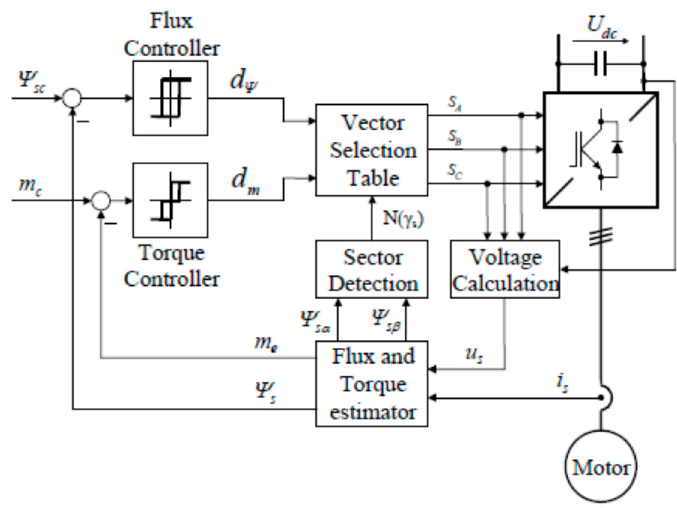
Figure 1. A block diagram of the Switching Table Based Direct Torque Control with circular stator flux path.